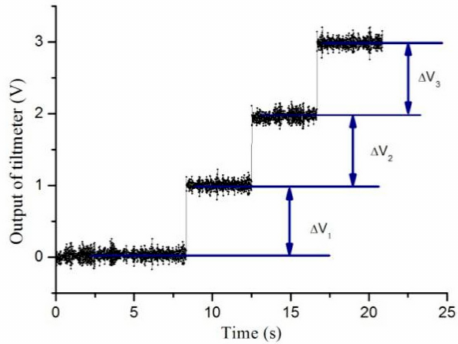
Figure 6. Calibration curve of the